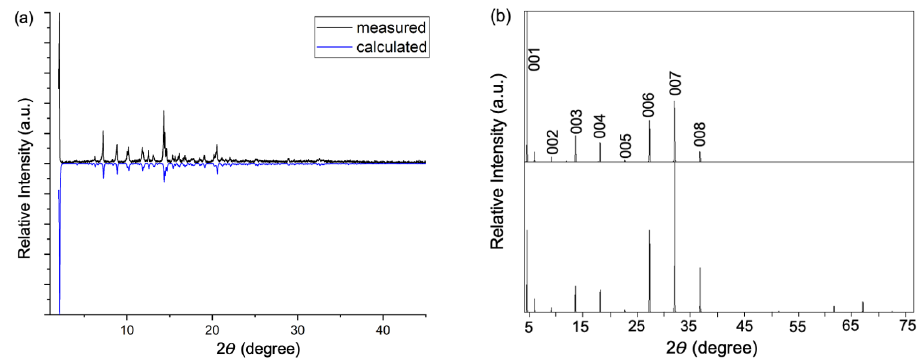
Figure 3. PXRD pattern (Mo-Ka1 radiation source) for (BA) 2 CsAgBibr 7 ( a ) and XRD patterns (Cu-Ka radiation source) for the single crystals Exp1 (bottom) and Exp 2 (top) ( b ).